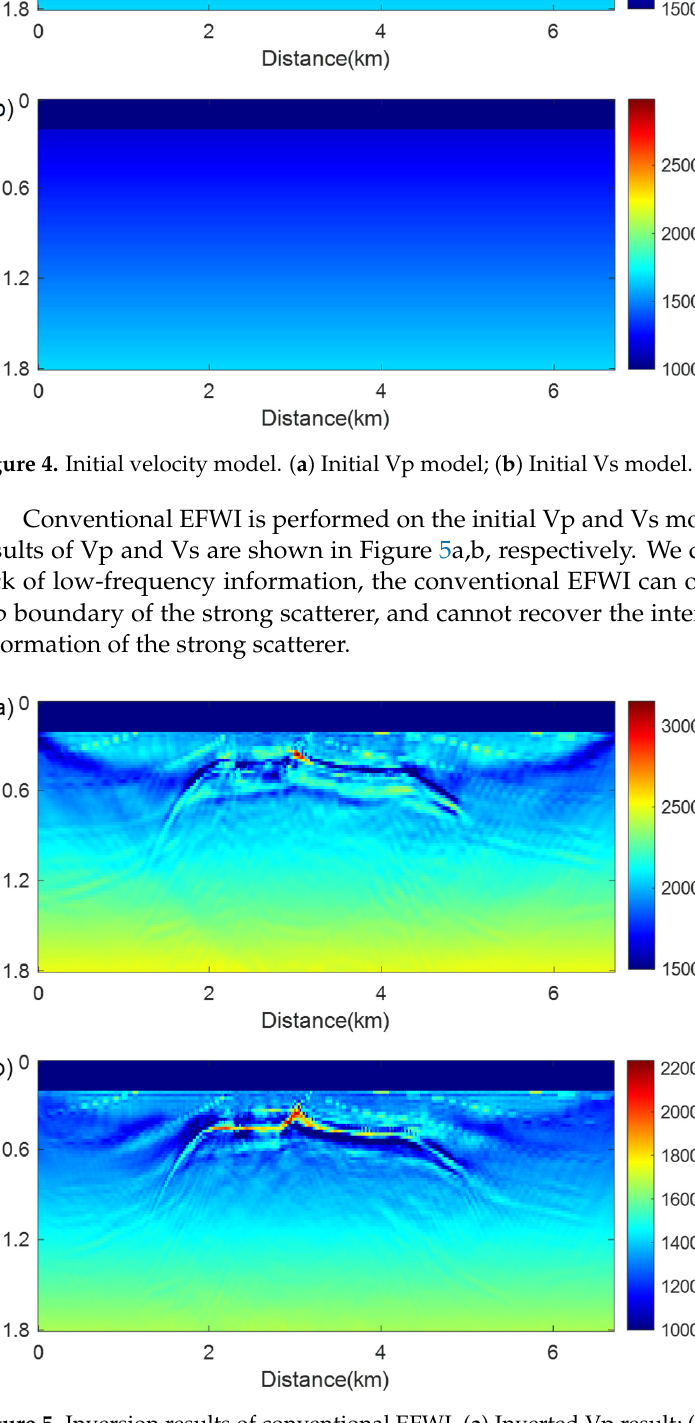
Figure 5. Inversion results of conventional EFWI. ( a ) Inverted Vp result; ( b ) Inverted Vs result.